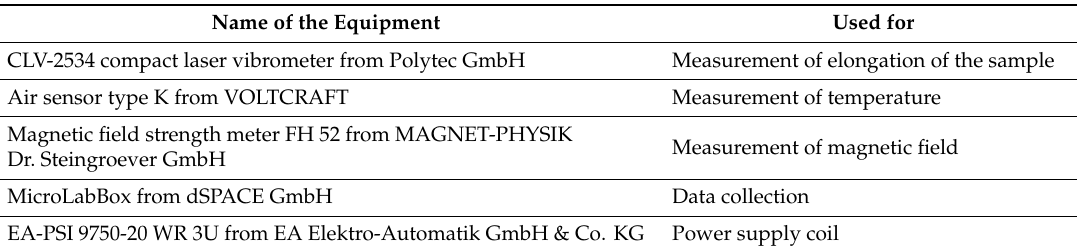
Table 2. Measurement equipment of all experiments.